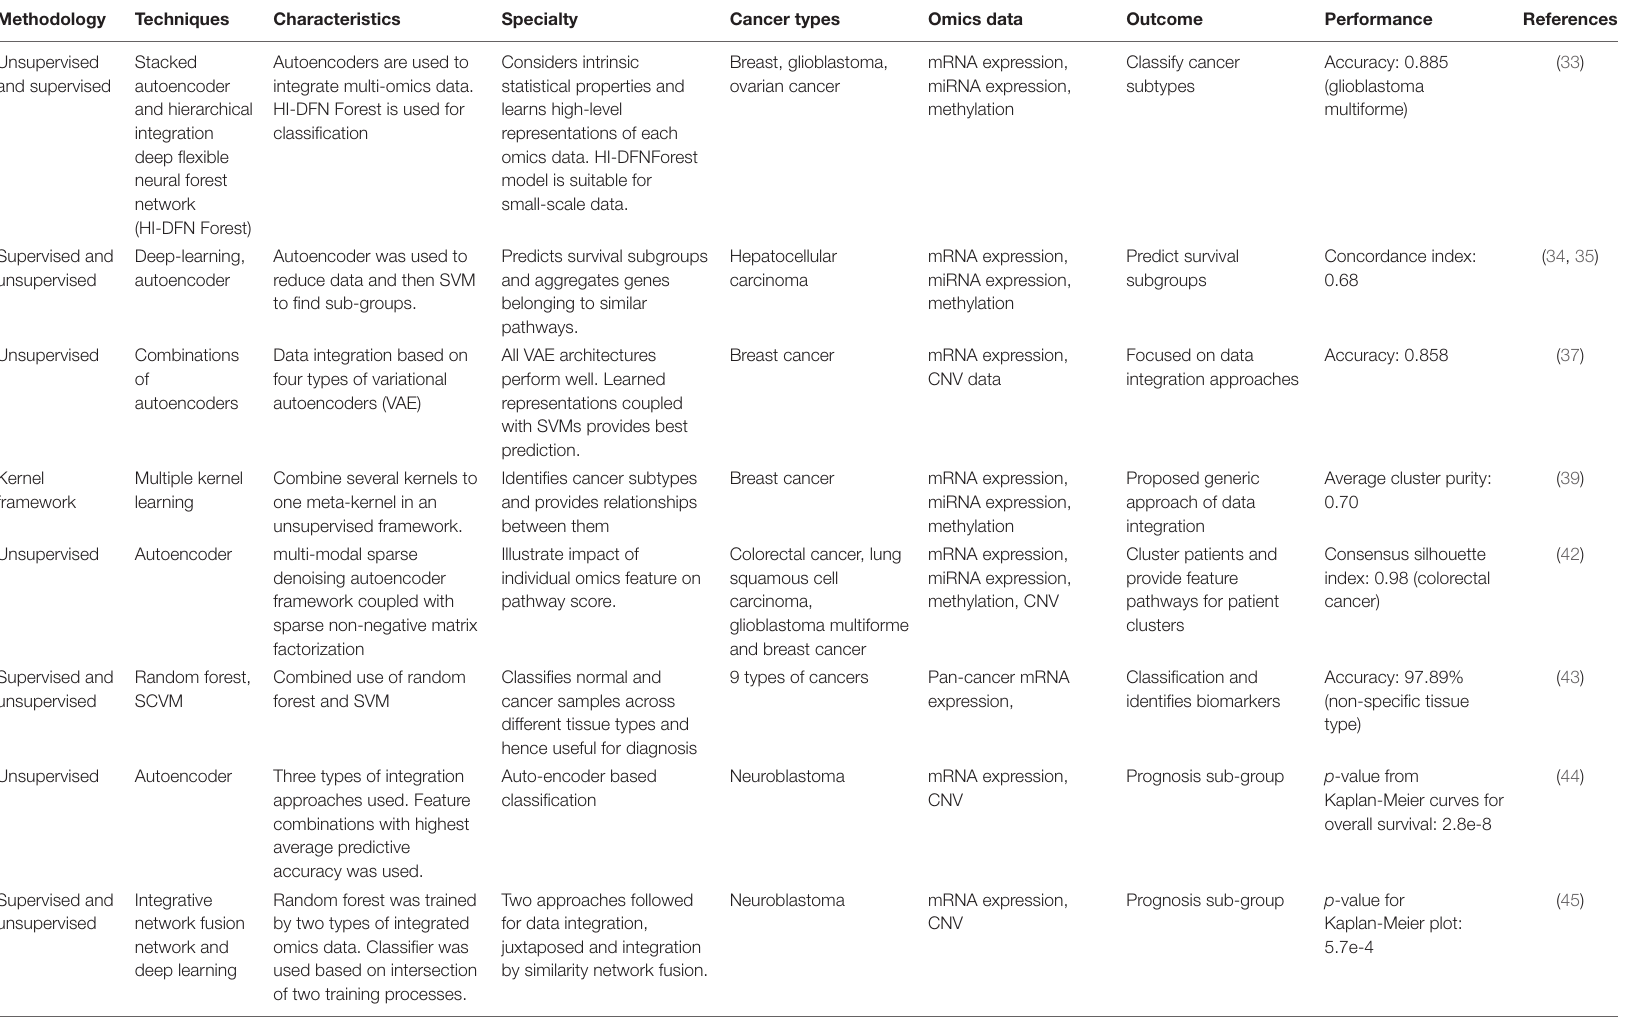
TABLE 1 | Features of recent methodologies and techniques used for AI based systems biology approaches in multi-omics data analysis of